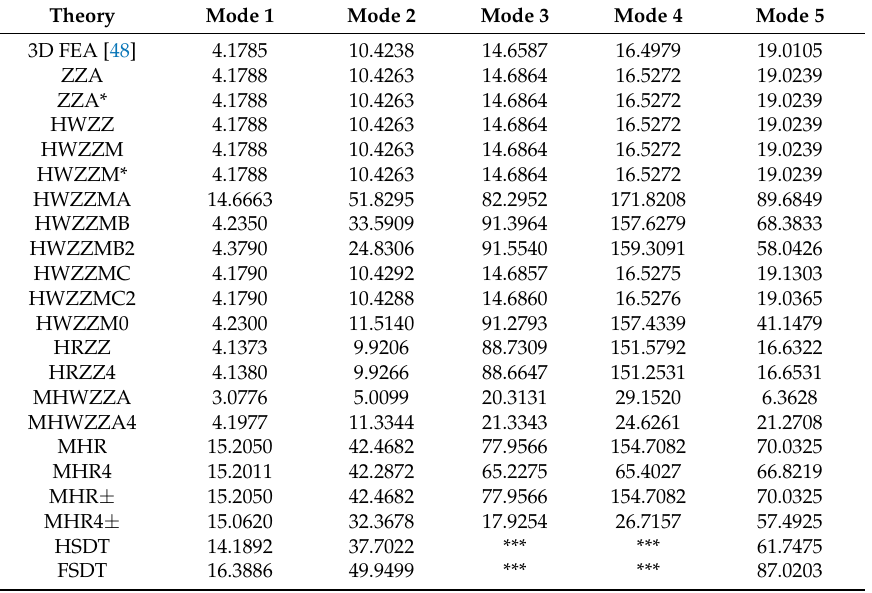
Table 18. Normalized fundamental frequencies, case g.